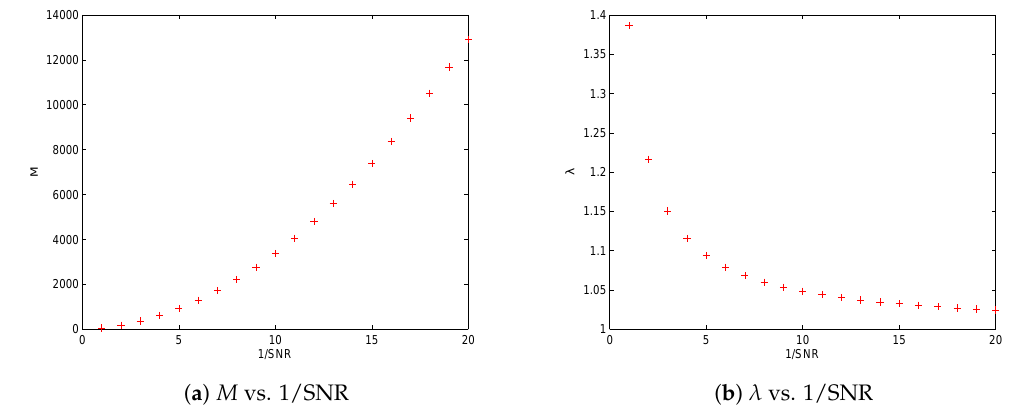
, k = 1,2, . . . ,20, under setting k